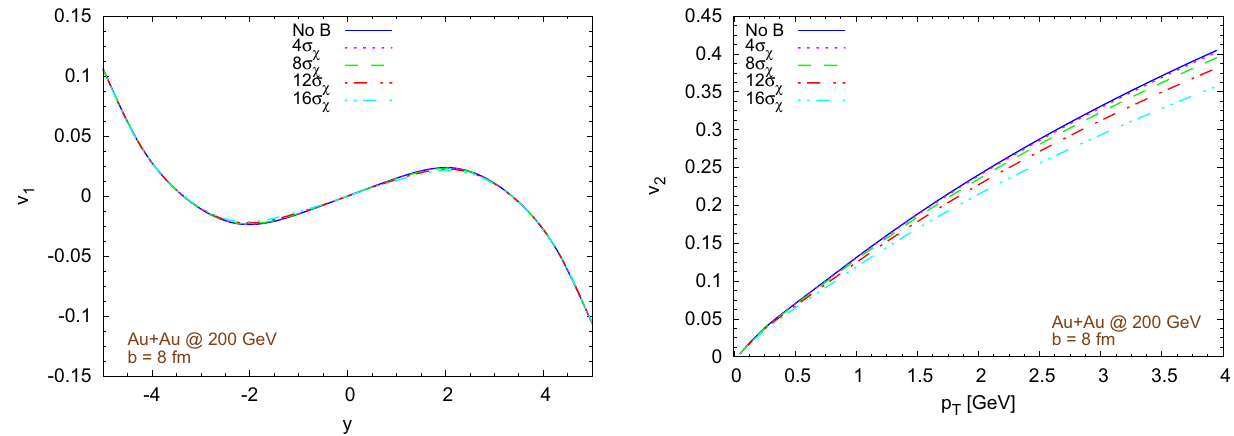
Fig. 7 Evaluation of the effects of a magnetic field of chiral origin only, amplified by factors 4, 8, 12, and 16, on v 1 ( y ) (left) and v 2 ( p T , y = 0 ) √ s NN = 200GeV with a fixed b = (right), in Au+Au collisions at